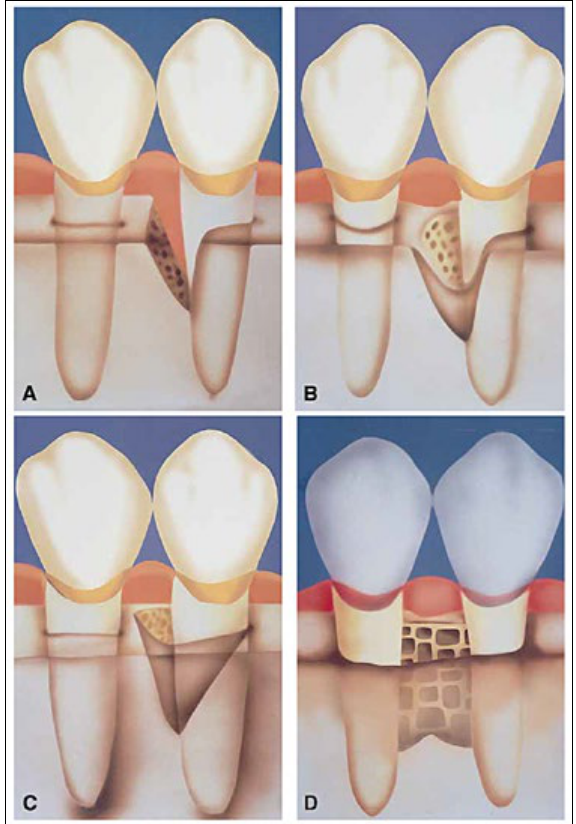
Figure 2. Infrabony defects. A. One-wall infrabony defect. B. Two-wall infrabony defect. C. Three-wall infrabony defect. D. Interproximal crater. Reprinted with permission from Papapanou and Tonetti. 84 Copyright 2003 by John Wiley and